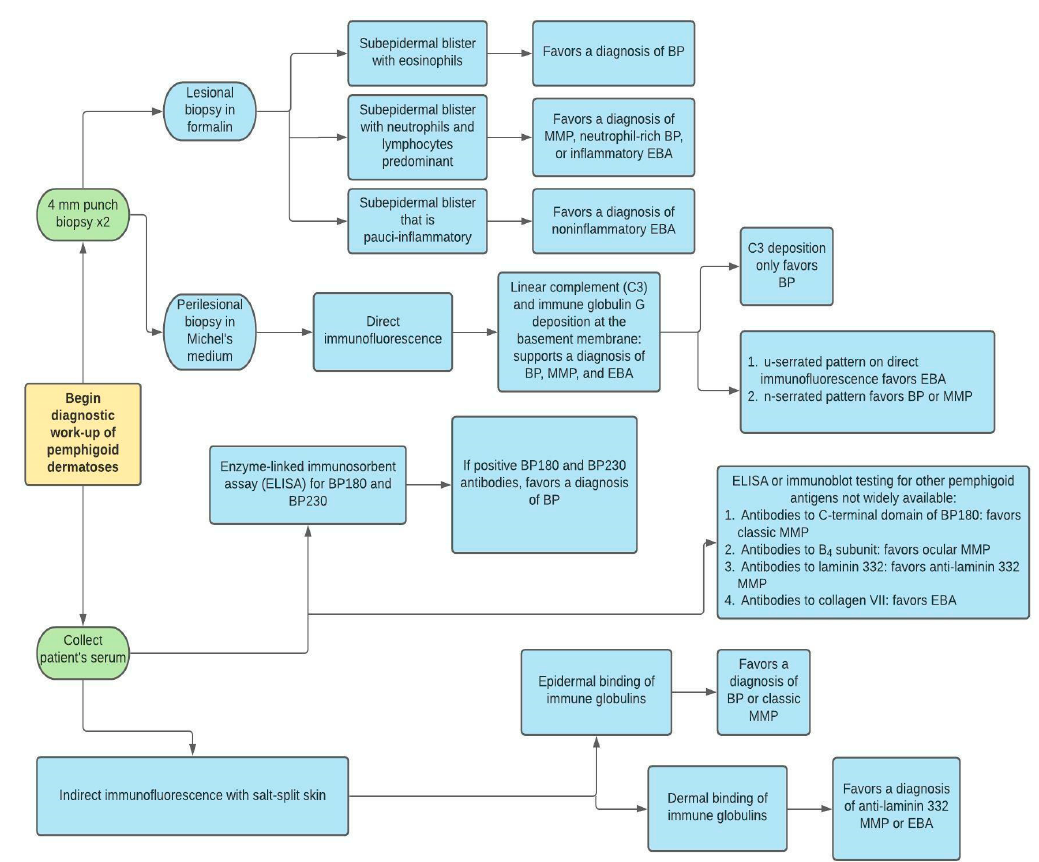
Figure 2. Diagnostic work-up of pemphigoid dermatoses. BP = bullous pemphigoid, MMP = mucous membrane pemphigoid, EBA = epidermolysis bullosa acquisita.